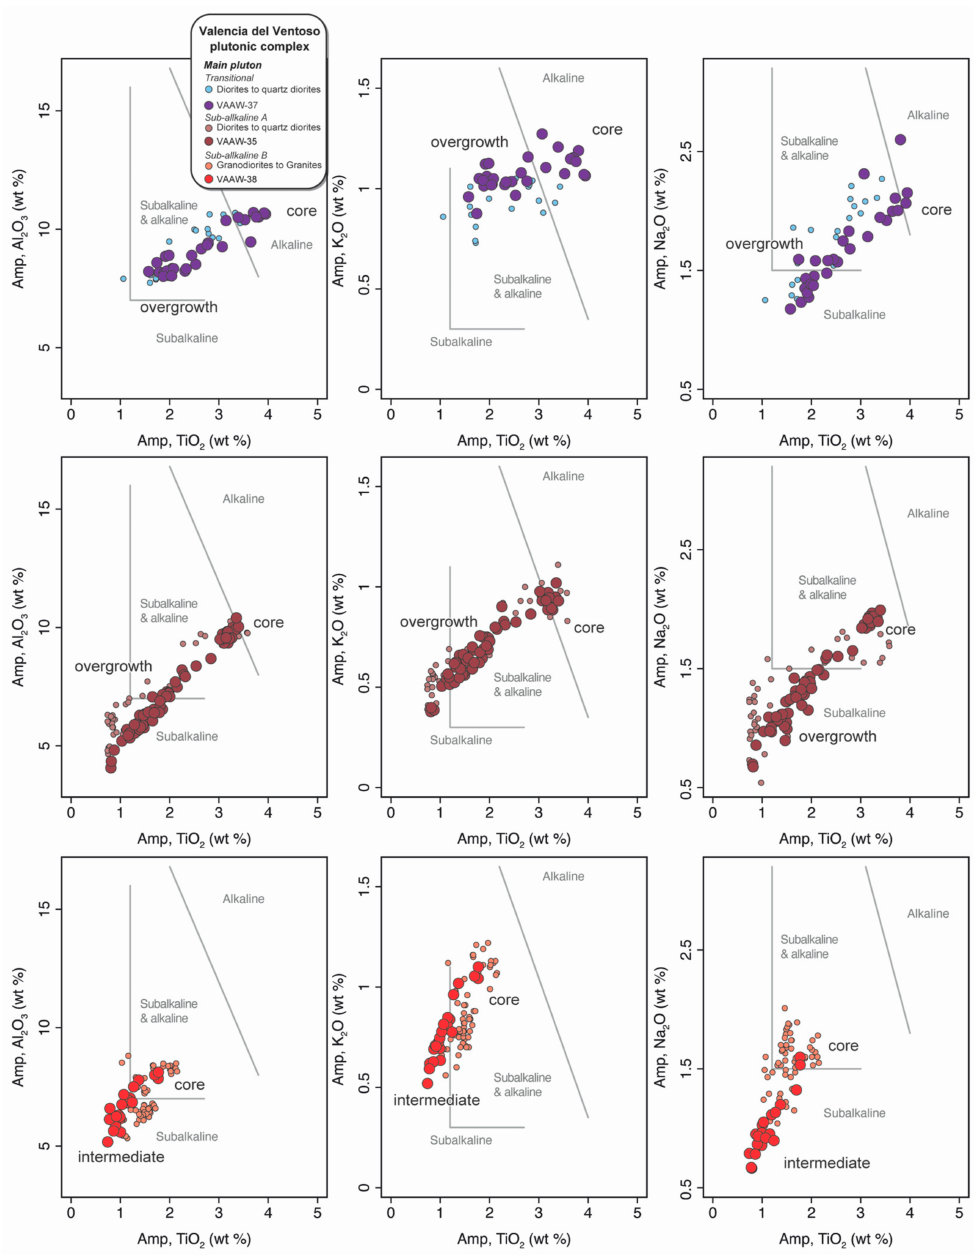
Figure 9. Composition of magmatic amphibole from intermediate and border facies rocks from the Valencia del Ventoso main pluton. Al 2 O 3 (wt.%) versus TiO 2 (wt.%), K 2 O (wt.%) versus TiO 2 (wt.%), and Na 2 O (wt.%) versus TiO 2 (wt.%) with compositional fields for alkaline and subalkaline melts as proposed by [2]. Compositional data of amphibole from [44] (smaller lighter symbols) are shown for